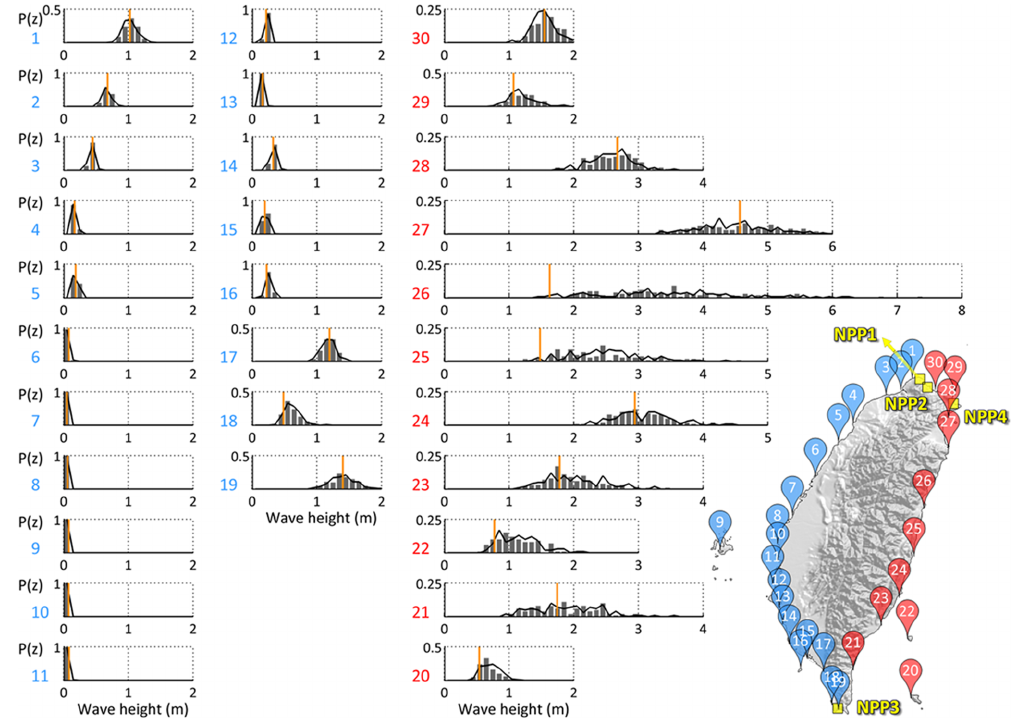
Figure 5. The probabilities of the PTA along the coast of Taiwan (blue: stations 1 ∼ 19, red: stations 20 ∼ 30). The histograms display the PTAs derived from 100 different slip simulations. The black lines represent the results from another 100 simulations, and the orange lines represent the PTA obtained using a uniform slip distribution. The PTA probability distribution gives a clear PTA range and its occurring probability. The map of Taiwan shows the station locations and the sites of four NPPs (yellow